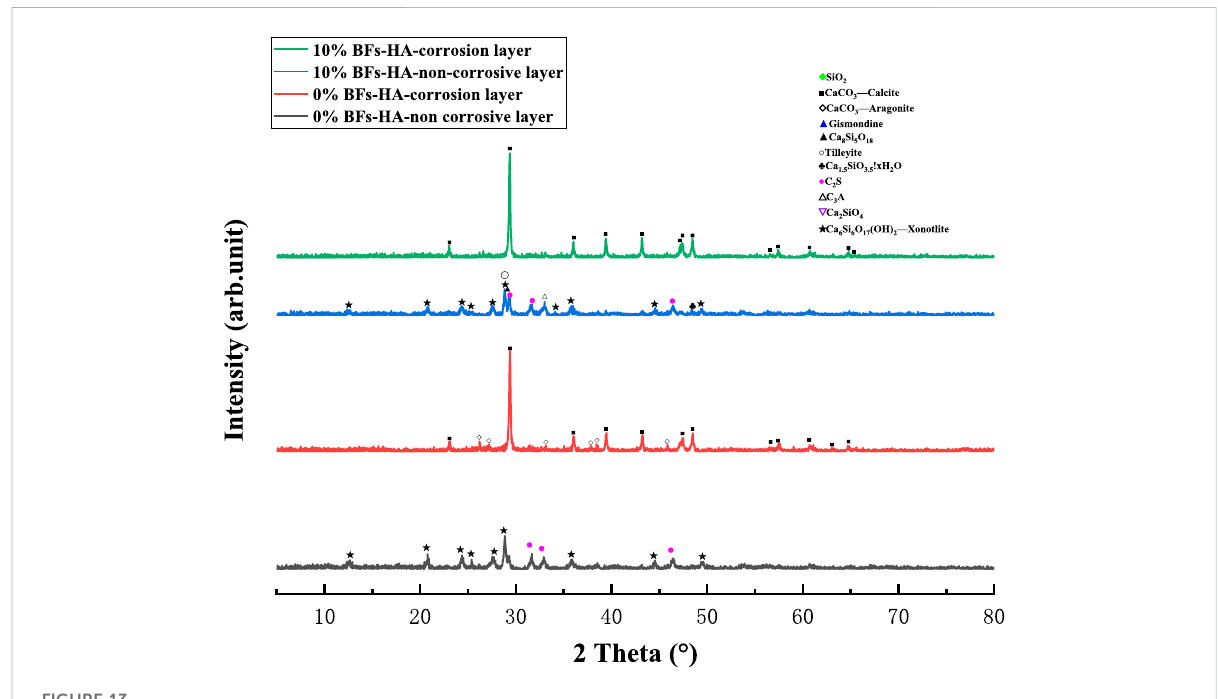
FIGURE 13 XRD spectrum of BFs-HA-composite emulsion-based cement paste corroded inside and outside.